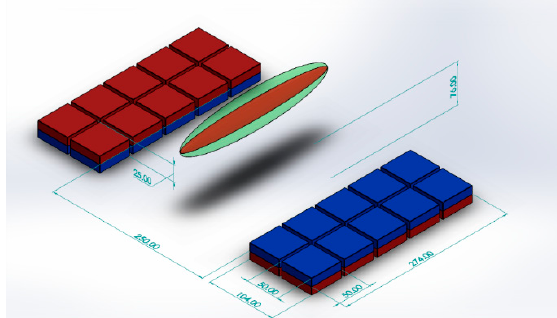
Figure 1. Schematic diagram of magnet array showing position of the ‘sweet spot’.